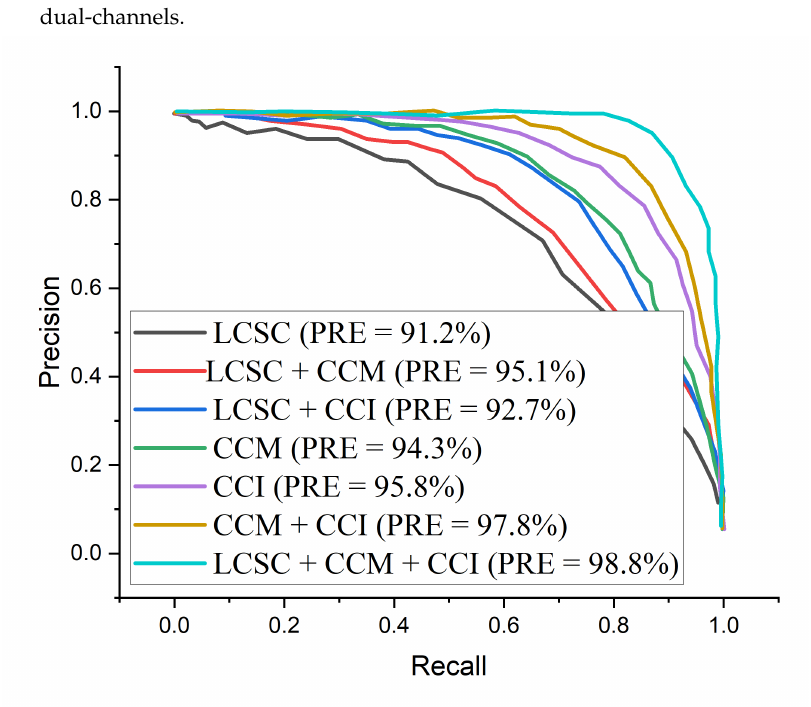
Figure 13. Precision–recall curves for the proposed multi-channel in comparison with the single- channels and